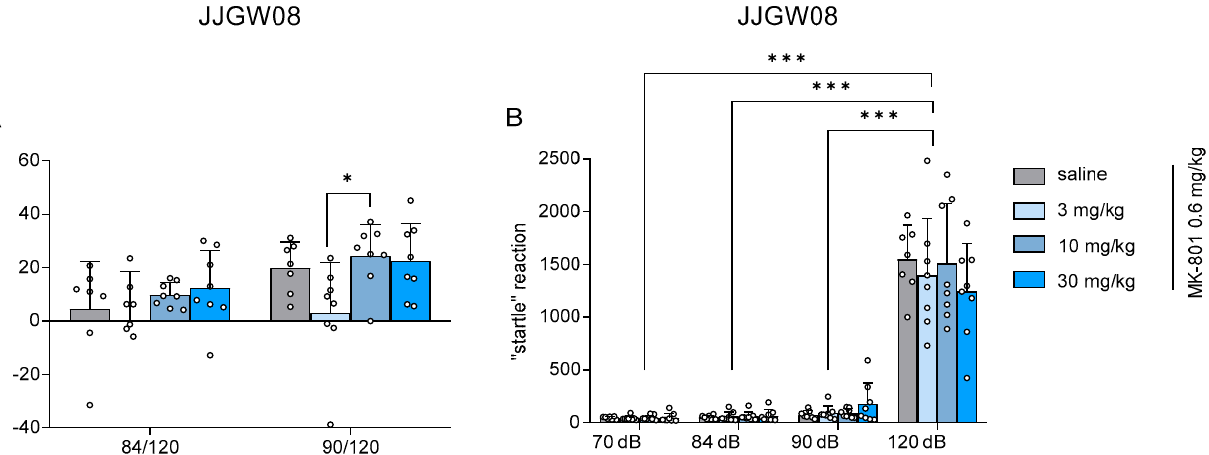
Figure 4. The effect of JJGW08 and clozapine on MK-801-induced hyperlocomotion in rats. After the habituation period (30 min, 24 h before the test), locomotor activity was measured individually for each animal in the special apparatus. The walked distance (cm) was monitored at 10-min intervals for 30 min, using a computerized system that tracked the animals’ movement and behavior. JJGW08 and clozapine were administered intraperitoneally ( ip ) 30 or 60 min before the test, respectively, while MK-801 (0.3 mg/kg) was administered ip 15 min before the start of the experiment. The control group received 0.9% NaCl solution ( ip ) (or 1% Tween ( ip ) for clozapine) and MK-801 (0.3 mg/kg, ip ). Values are expressed as mean ± SD, n = 7–8 rats per group. Statistical analysis: one-way ANOVA (Newman–Keuls post hoc ) * p < 0.05, ** p < 0.01, *** p < 0.001.